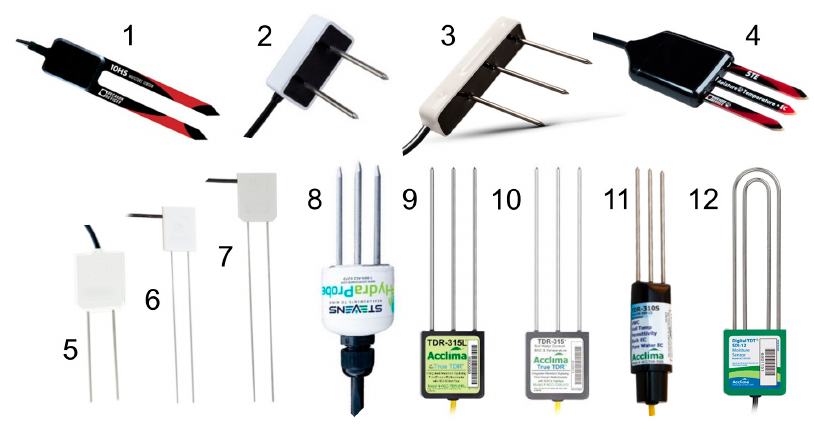
Figure 1. Soil moisture sensors from different manufacturers used in this study. (Table 1 shows the manufacturer information.)